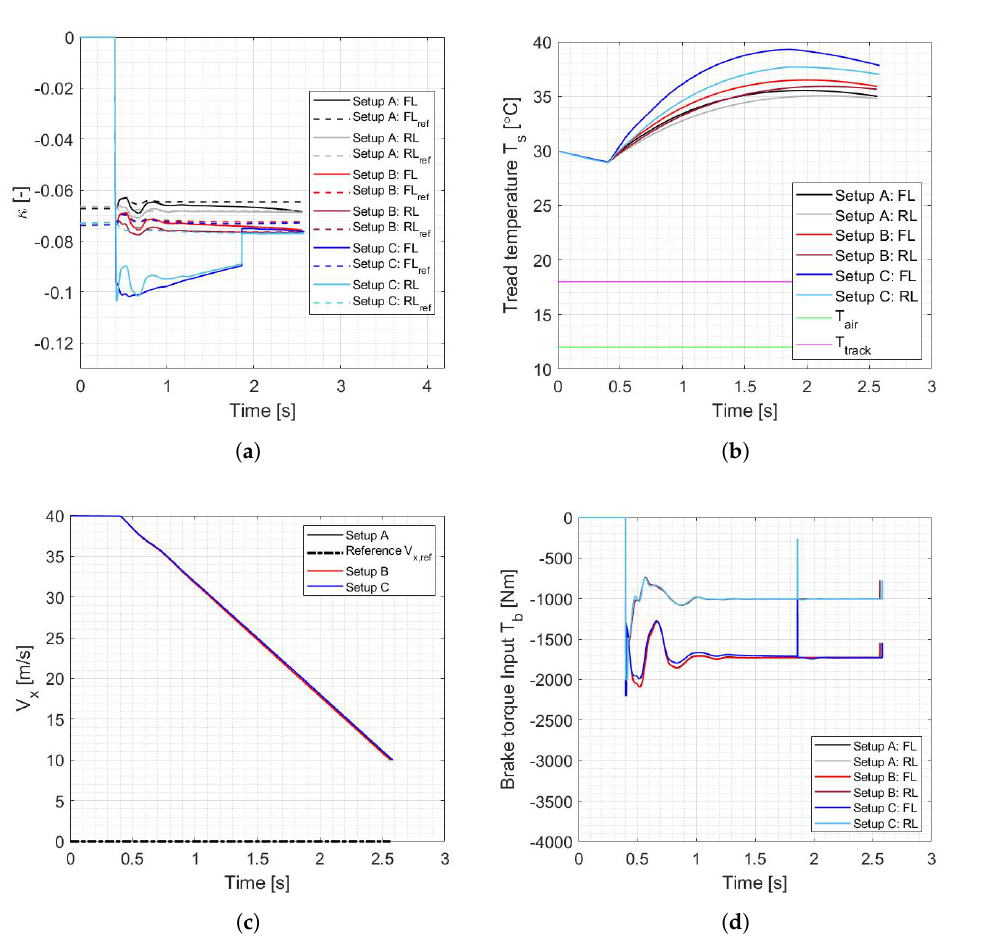
Figure 26. Time histories of states and control inputs for the 3 setups of full-car NMPC ABS controller in test 5 (Figure 20). ( a ) Longitudinal slip κ 1/3 . ( b ) Tread temperatures T s 1/3 . ( c ) Vehicle longitudinal velocity V x . ( d ) Brake torque control input T b 1/3